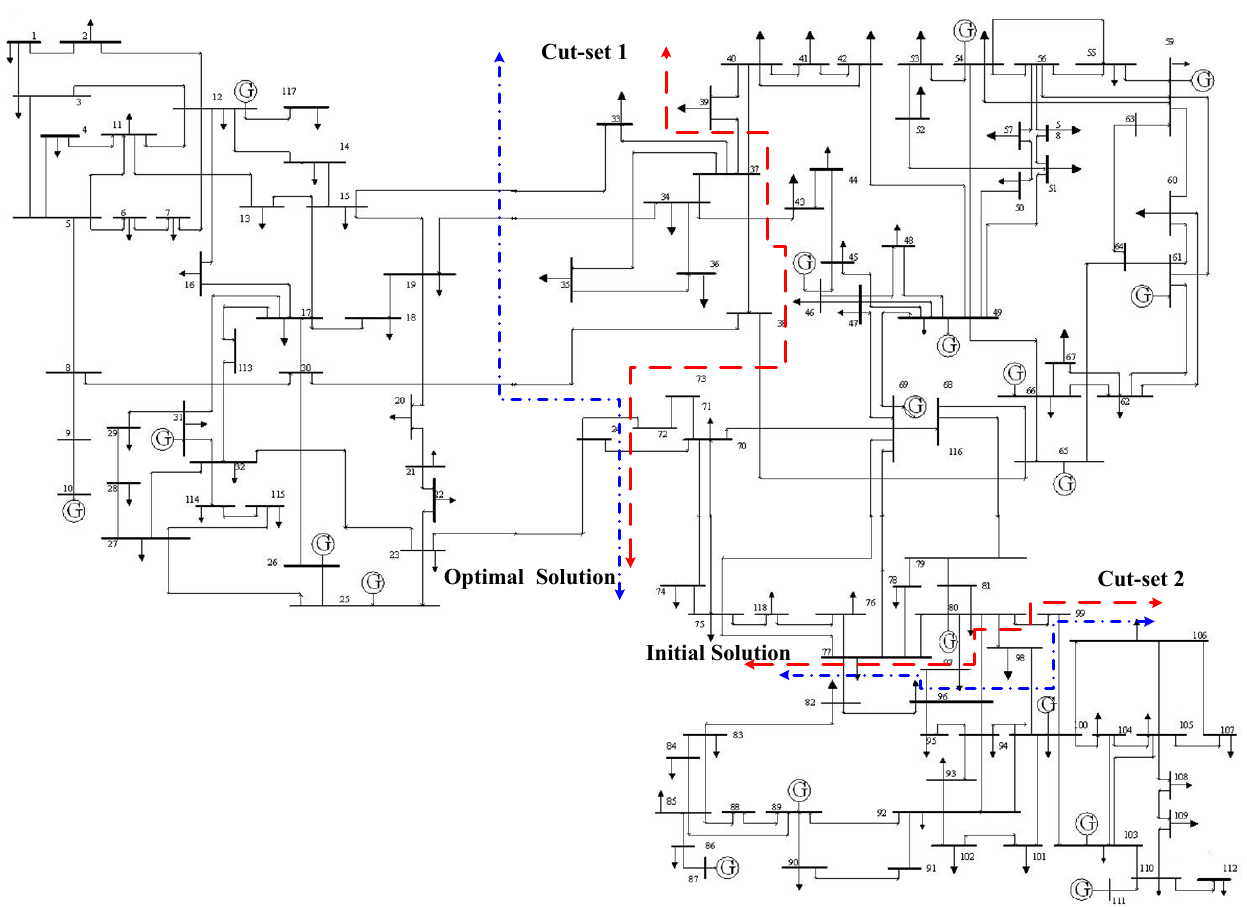
Figure 9. Topology graph of the IEEE 118-bus power